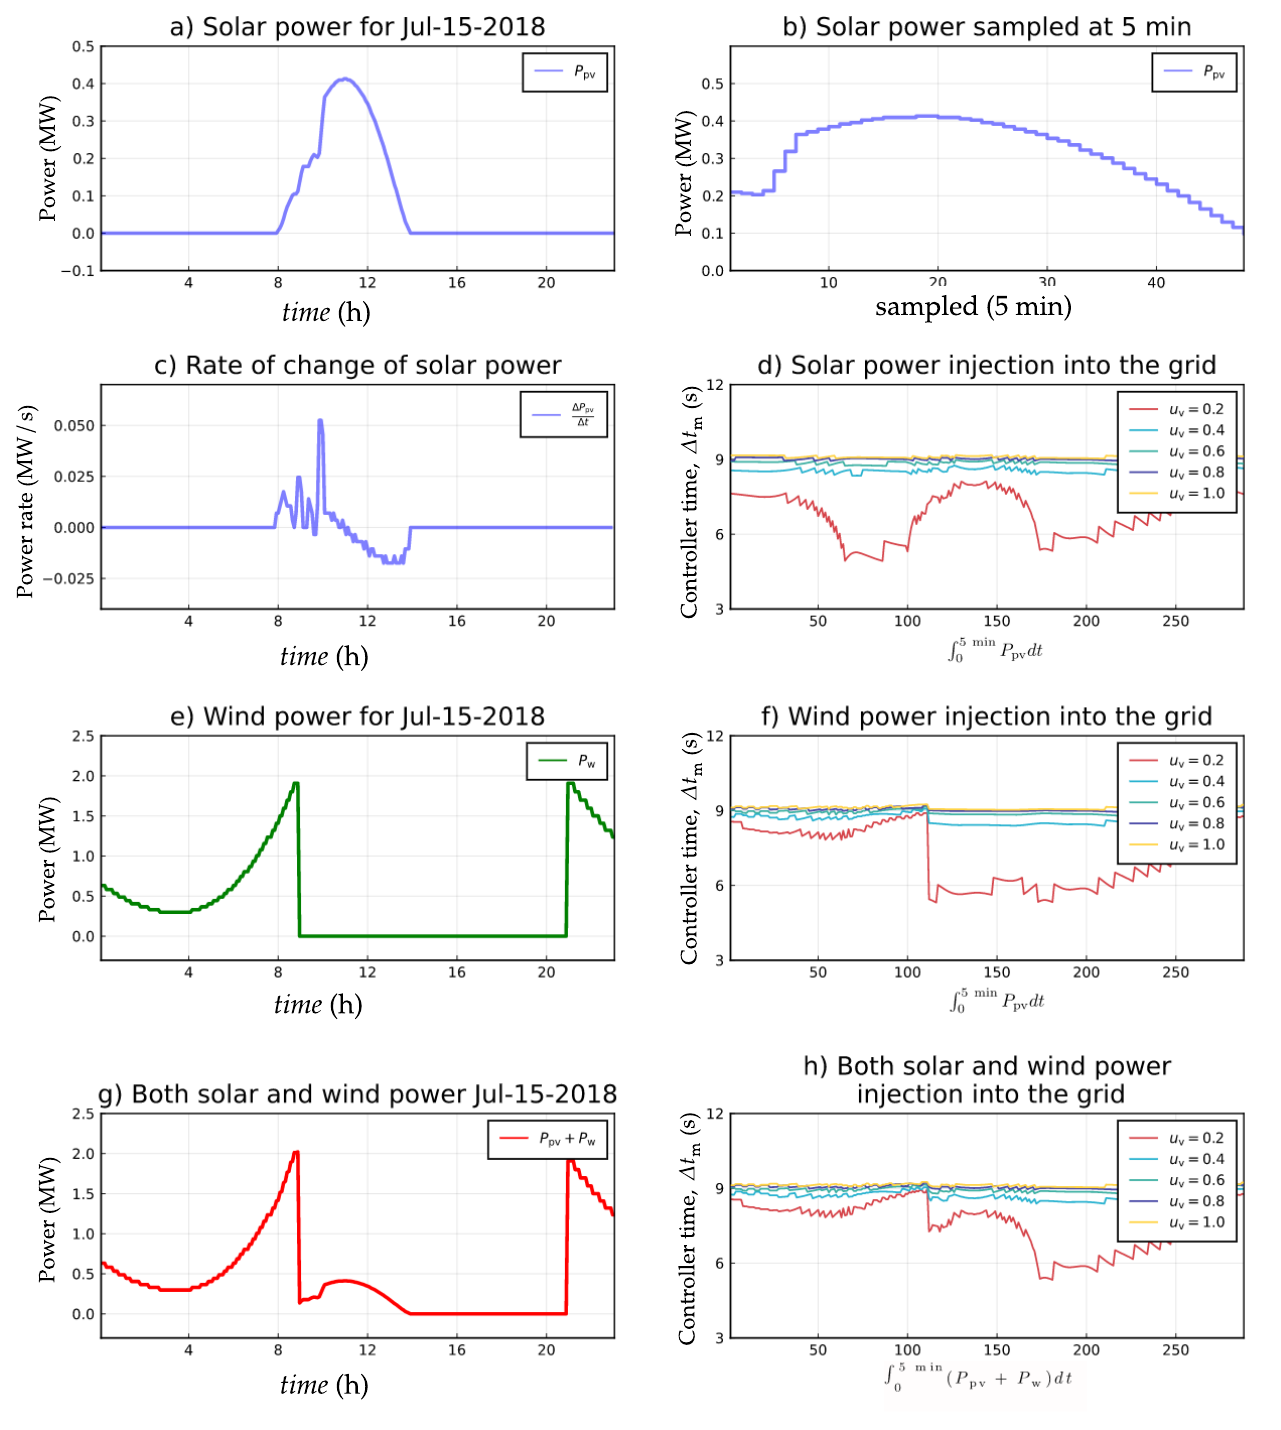
Figure 5. Intermittent power injection into the grid to study limits on ∆ t m